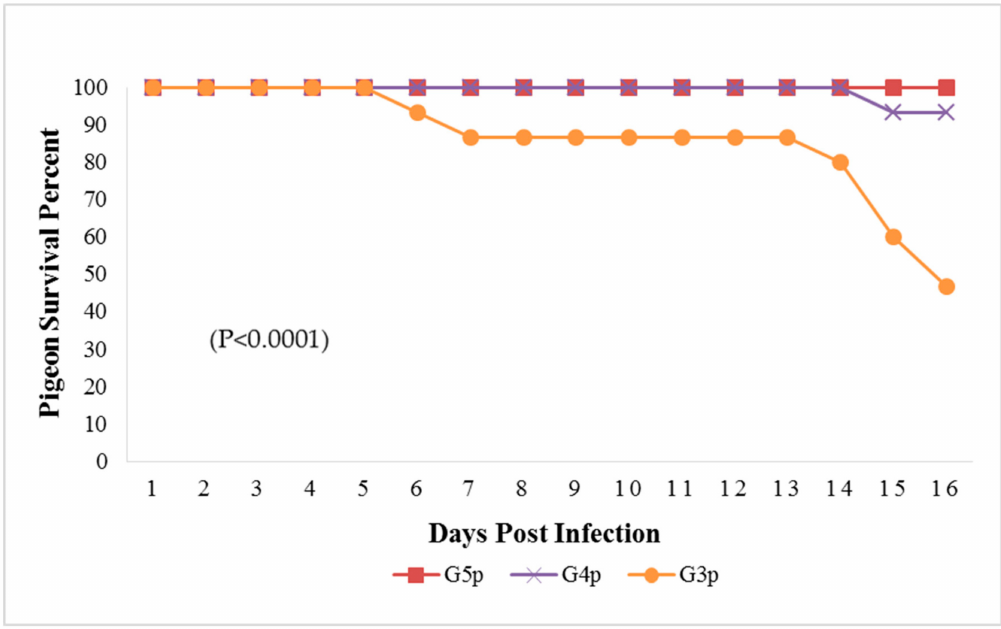
Figure 4. Survival percent in pigeon groups until the 16th dpi analyzed by Chi-square test using statistical analysis system SAS; data frequencies were significant at ( p < 0.0001). G3p: n = 15, G4p: n = 15, and G5p: n = 10.